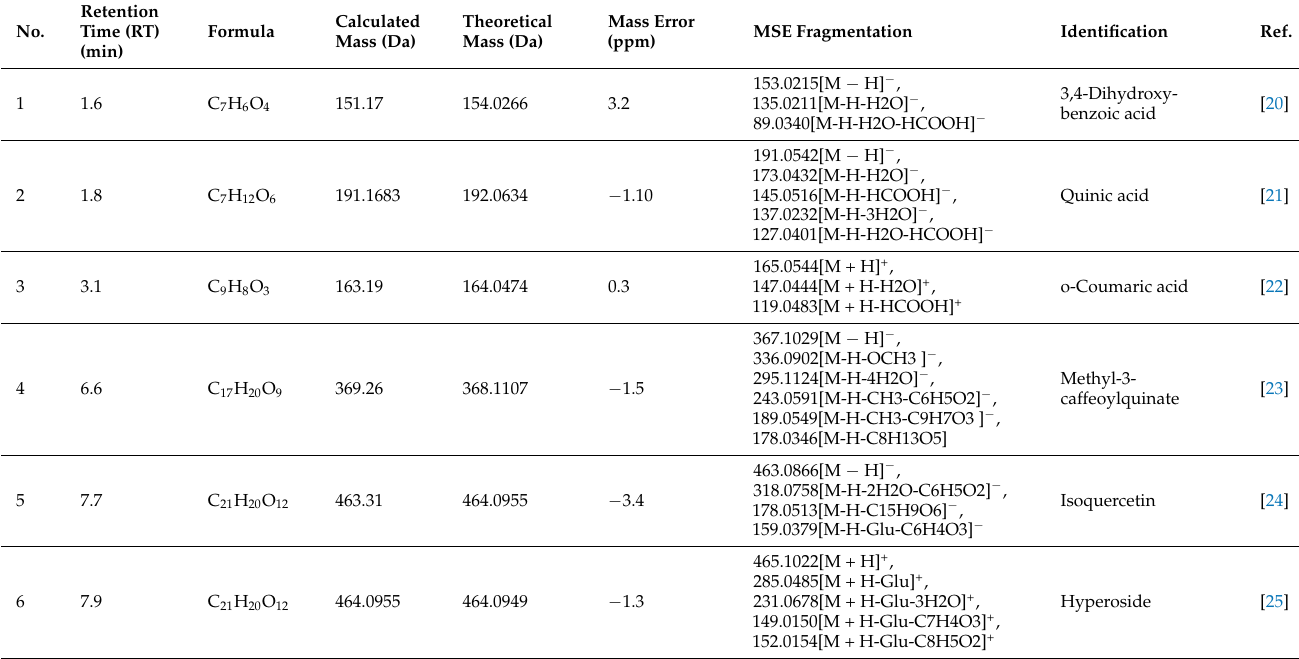
Table 1. List of compounds revealed by LC-MS analysis of Moringa